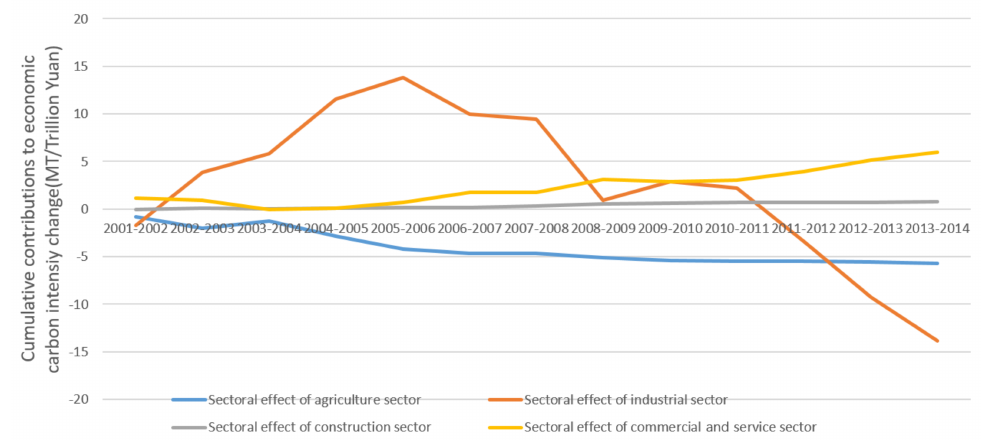
Figure 5. Cumulative Contributions of the Sectoral Structure Change to the Economic Carbon Intensity Change.